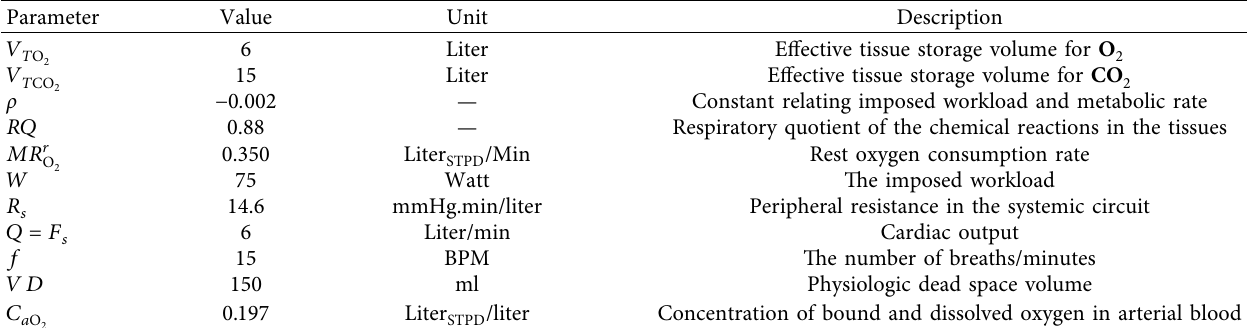
Figure 1: Diagram of exchange of pressures for 4 compartments of mathematical model of human cardiovascular-respiratory system during and f denote logistic functions. The parameters MR physical activity. f 1 2 and the metabolic carbon dioxide production rate, respectively, during physical activity. F s denotes blood flowing into the tissue compartment. Table 2: Value of parameters collected from the literature (see [18]).